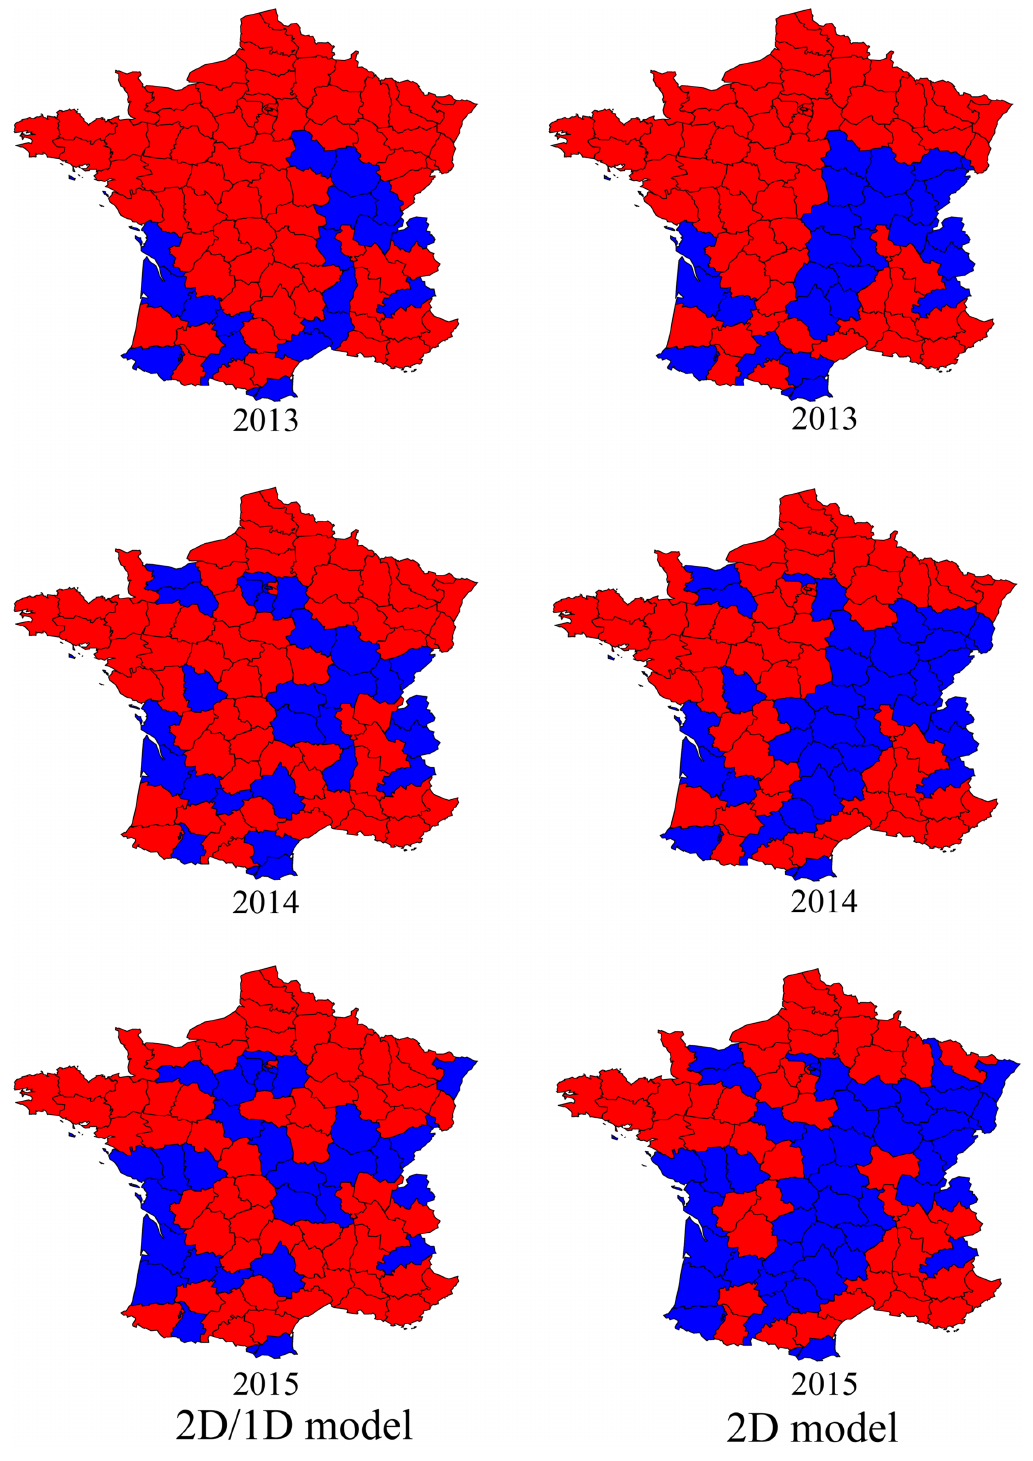
Fig 6. Predictive power. Red departments indicate a good prediction: the event (0 = absent, 1 = introduced or 2 = established) which was predicted with the highest probability is the event which actually occurred. Blue departments indicate an incorrect prediction: the event which was predicted with the highest probability is not the event which actually occurred. The model parameters Y (cid:9) estimation, based on the data of the training period 2004 – 2012.